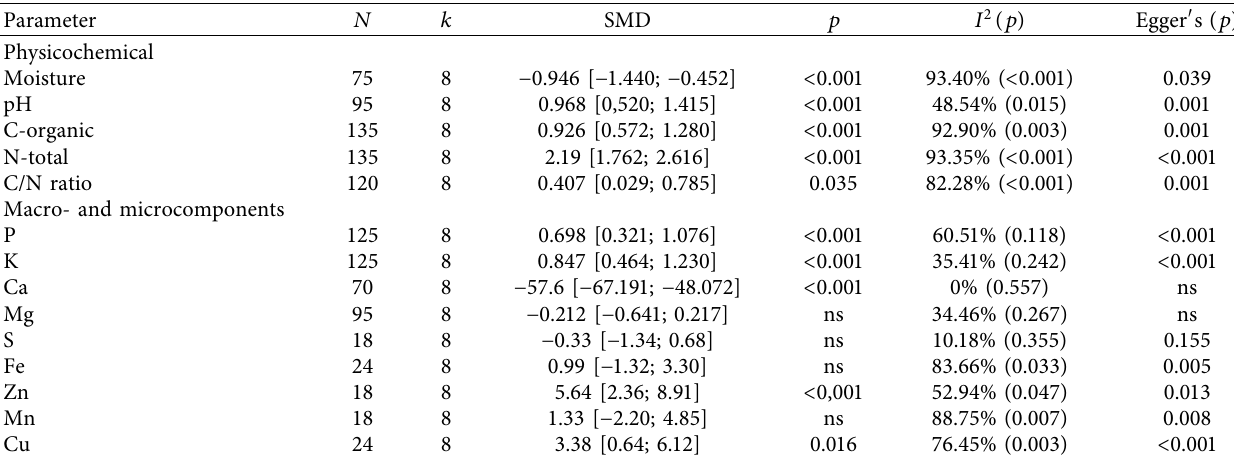
Table 5: Te analysis results on physicochemical parameters and macro- and micronutrient content of palm oil waste compost. Parameter